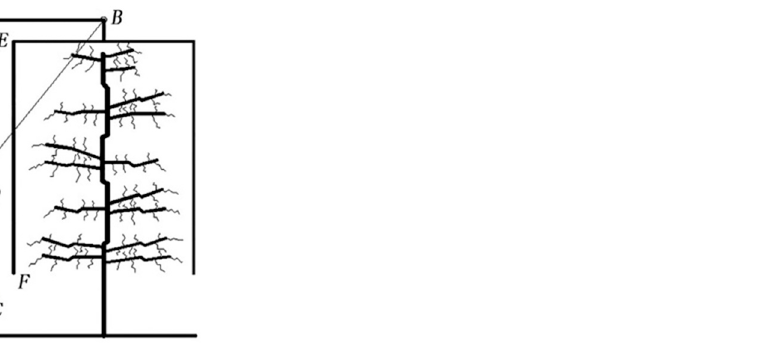
Figure 9. Geometric diagram of adjustment frame. Note: OA stands for the adjustment range of vertical beam height, which is 1450~2250 mm; AB represents the beam, which is 1100 mm in length; OG is the height between the hinge point of the outer sleeve for the vertical beam and the ground, 350 mm; OC is the distance from the outer edge of the tractor near the side pruning assembly to the hinge point of the outer sleeve for the vertical beam, and its length is 900 mm; CD is the outer edge of the tractor; GH is ground; EF is the outer contour of the maximum pruning position at which the side pruning assembly is located (i.e., the crown radius of the trim is 700 mm); α is the maximum adjustment angle of the adjustment frame.